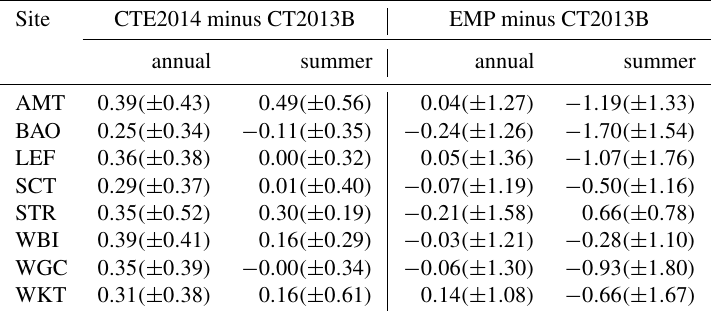
Table 3. Contribution of lateral transport to simulated CO 2 mole fractions at the tall tower network for three sets of lateral BCs. The mean differences (in ppm) between CTE2014, EMP, and CT2013B BCs are calculated for 2010 and summer (JJA), respectively. The standard deviation (1 σ ) of the differences for each tower site is given in the parenthesis.